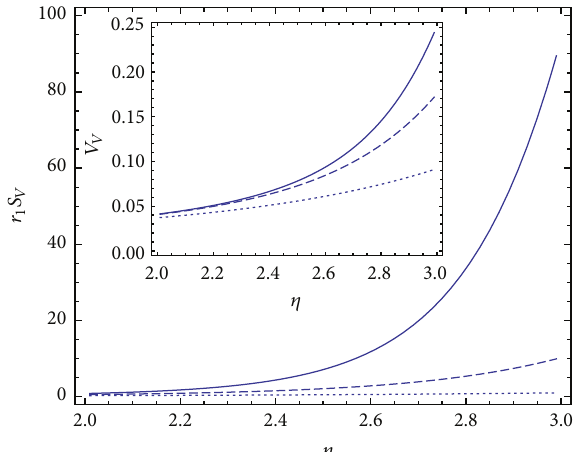
Figure 10: Volume fraction (insert) and specific surface area of self- similar Boolean models versus self-similar parameter 𝜂 ; 𝑟 1 = 1, ] 1 = 0.01 , and 𝑠 = 1; 𝜅 = 0.1 (dotted), 0.01 (dashed), and 0.001 (solid